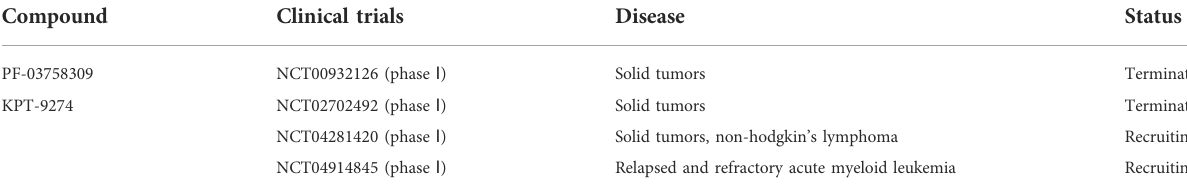
TABLE 2 Progress in clinical trials of PAK4